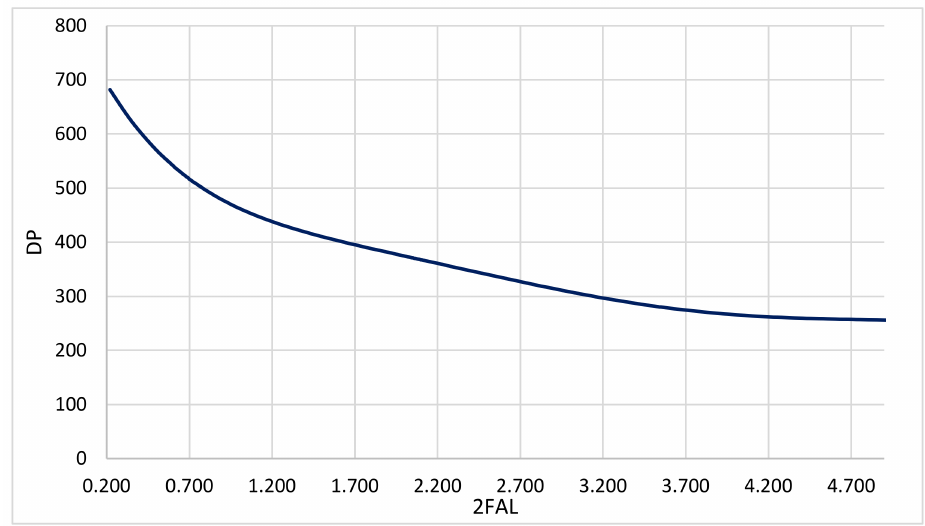
Figure 2. Databank: DP vs.